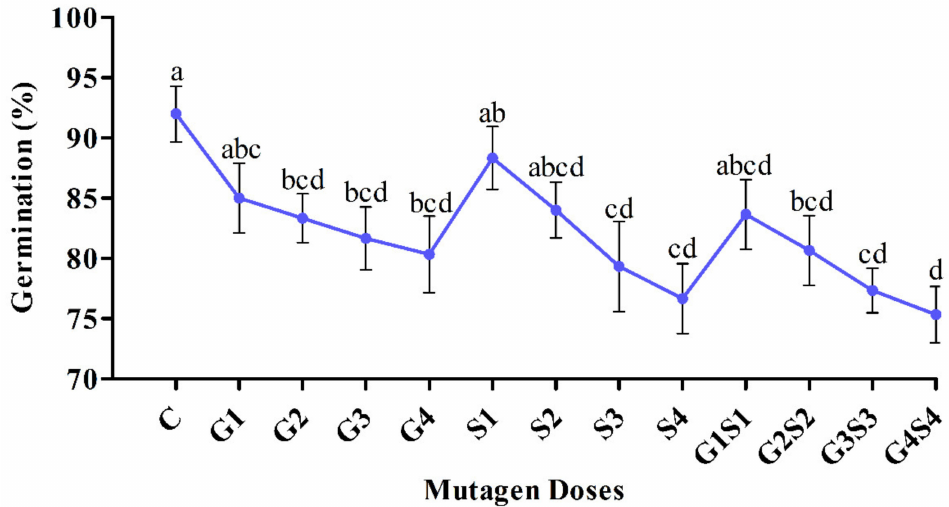
Figure 2. Effects of different doses of γ rays and SA on seed germination in var. Pusa-578. The data is presented as percent (n = 300) and standard error. Line graphs with the same letters are not significant at a 5% level of significance, based on Duncan’s multiple range test